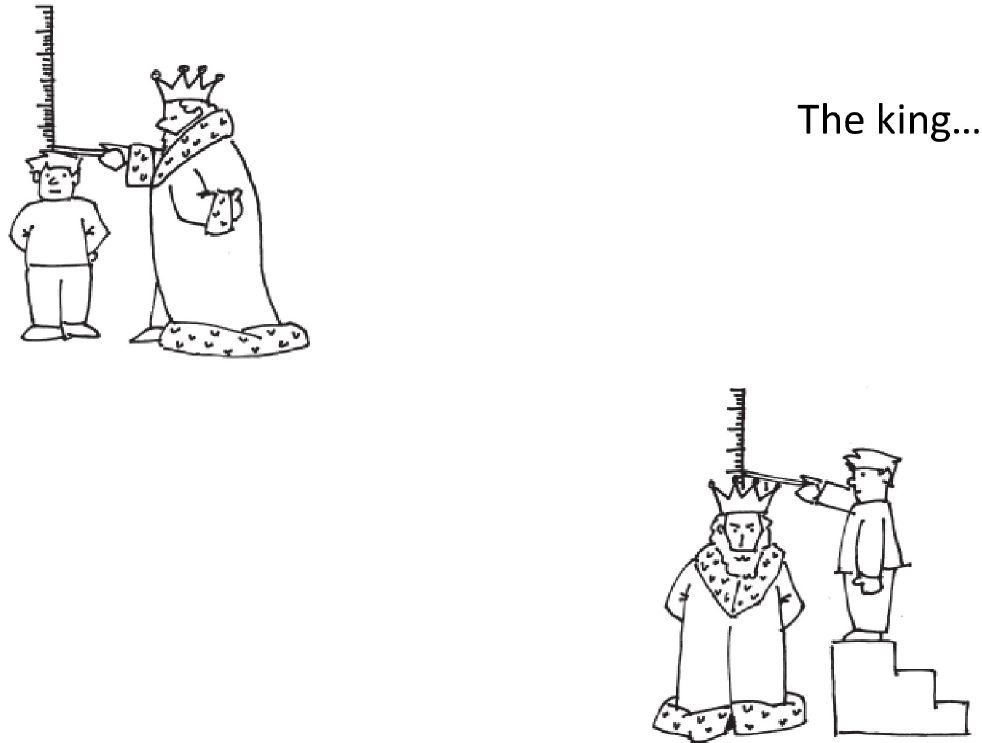
Fig 1. Example of a stimulus slide for the Passives production task (drawings Copyright by NAT-Verlag Hofheim, Germany).